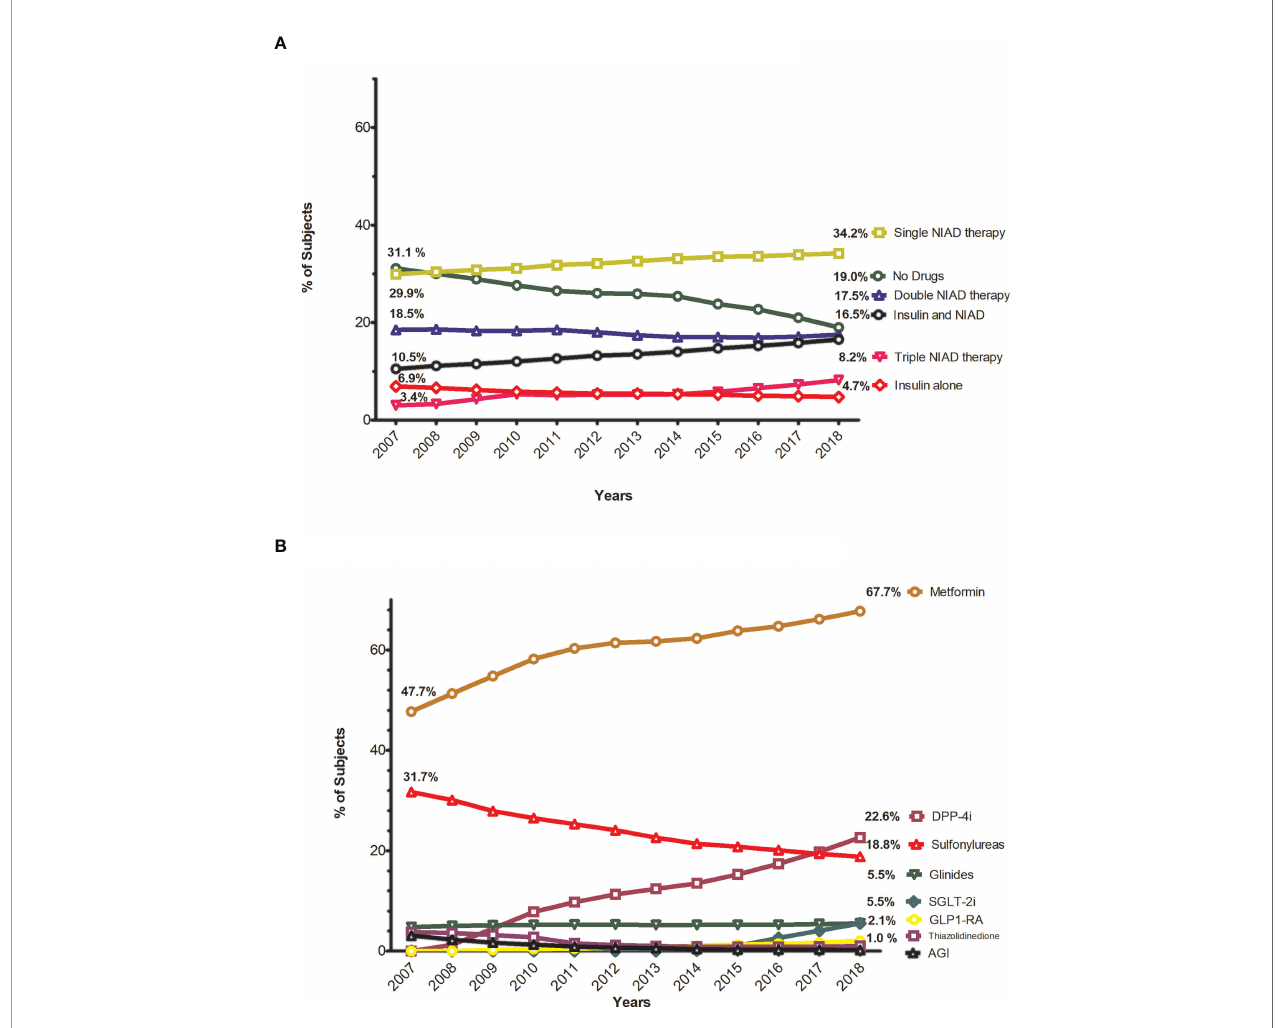
FIGURE 1 | Trends in the proportion of subjects by different steps of antidiabetic treatment and using non-insulin antidiabetic drugs. (A) Annual trends in the proportion of subjects by steps of antidiabetic treatment. (B) Annual trends in the proportion of subjects treated with non-insulin antidiabetice